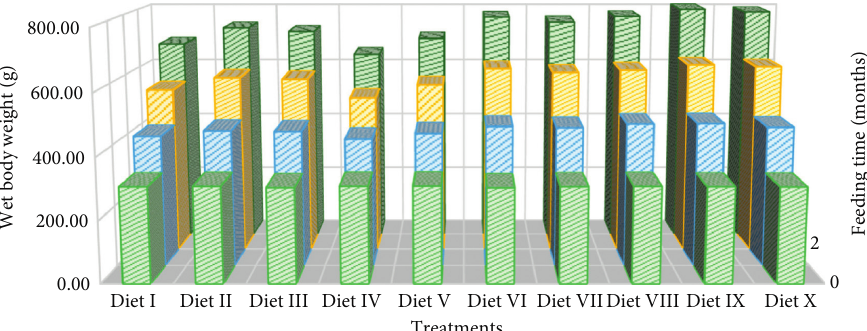
Figure 5: Weight variations of rainbow trout groups fed with different diet formulations. Feeding time of 0 indicates the initial time point where experimental feeding